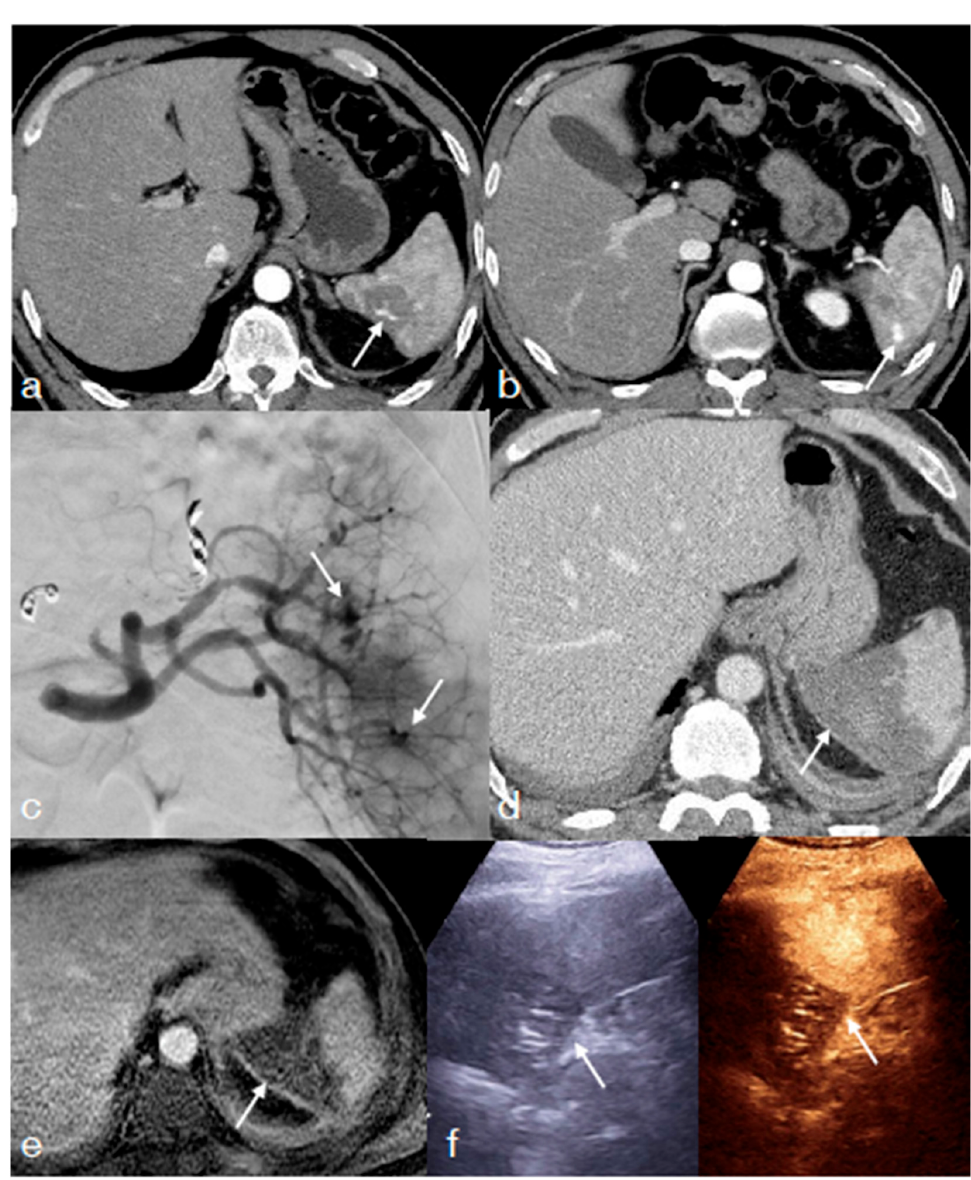
Figure 9. A fifty-year-old male patient underwent high-energy trauma and developing multiple contained vascular splenic injuries (( a , b ) arrows) confirmed at the following angiography (( c ) arrow) and embolized. In the subsequent follow-up, the patient was initially evaluated by enhanced CT, which detected the infarcted area due to embolization (( d ) arrow), and in the following days, by MRI (( e ) arrow) and CEUS (( f ) arrows), documenting the progressive healing of the lesion.